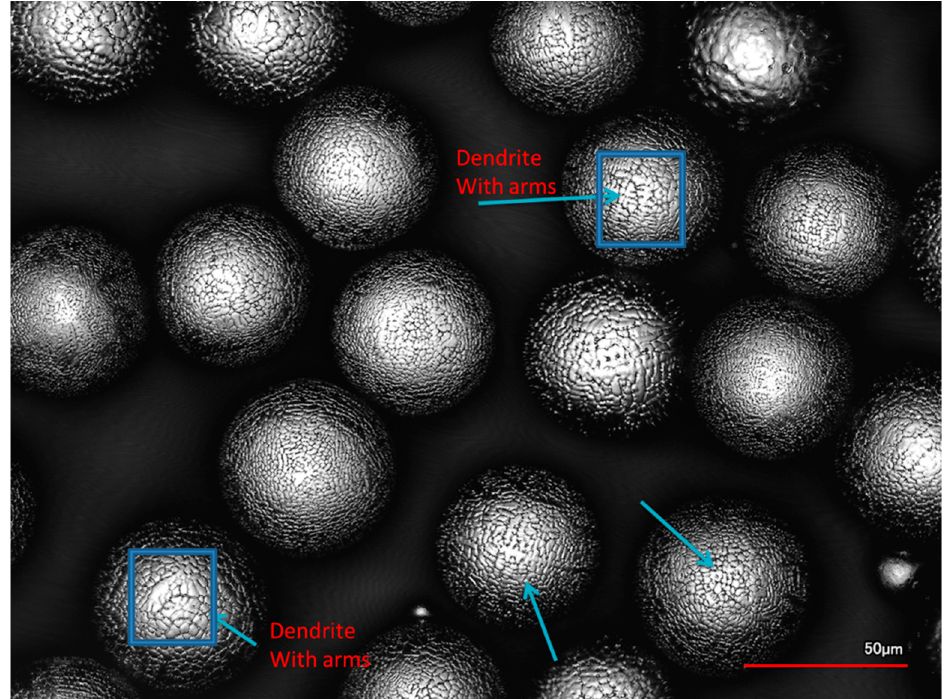
Figure 25. Three-dimensional (3D) laser scanning confocal micrograph of rapidly solidified Al 5056 powder from Company E. The dendritic solidification microstructures can be directly obtained in the micrograph.